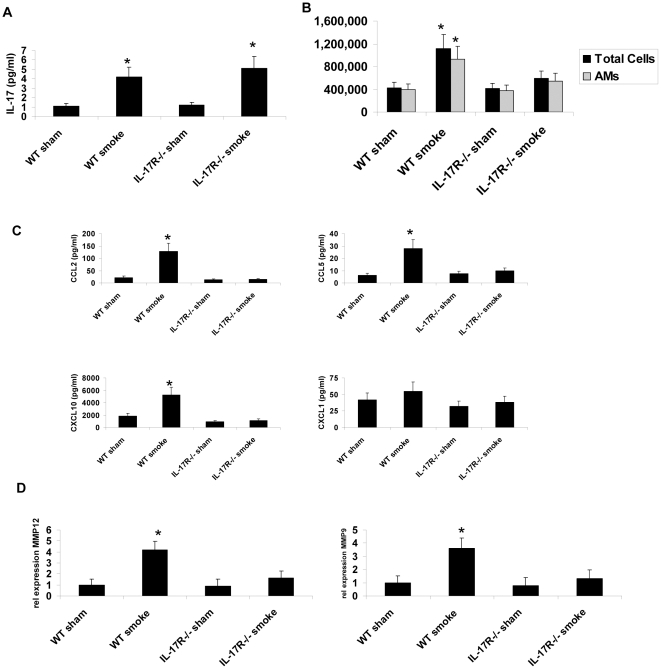
Requirement of IL-17RA for smoke induced lung inflammation.(A) BAL levels of IL-17 after six months of cigarette smoke exposure (n = 5–6 per group, * denotes p<0.05 compared to WT sham). (B) BAL total cells and alveolar macrophage numbers after 6 months of smoke exposure. (n = 5–6 per group, * denotes p<0.05 compared to WT sham) (C) Levels of CCL2, CCL5, CXCL10 and CXCL1 in lung homogenate after six months of cigarette smoke exposure (n-5–6 per group, * denotes p<0.05 compared to WT sham). (D) Expression of transcripts for MMP12 and MMP9 using RT2 Profiler PCR Array. The delta Ct values were calculated by individual gene Ct value minus that of the associated housekeeping gene and expressed as relative gene expression compared to the WT sham group (n-5–6 per group, * denotes p<0.05 compared to WT sham).